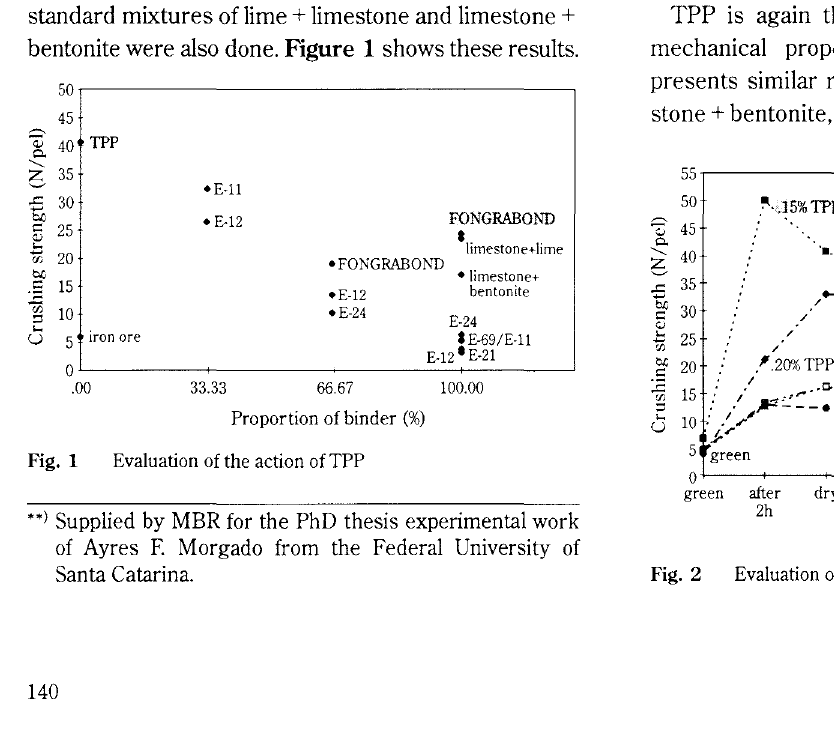
Fig. 1 Evaluation of the action of TPP **) Supplied by MBR for the PhD thesis experimental work of Ayres F. Morgado from the Federal University of Santa Catarina. Fig. 2 Evaluation of the variation of the dosage of